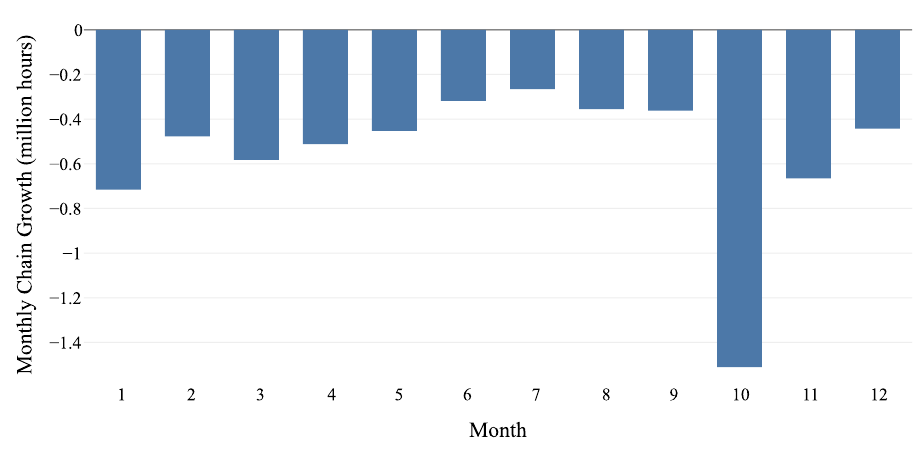
Figure 2. Global fishing effort from 2017 to 2020.